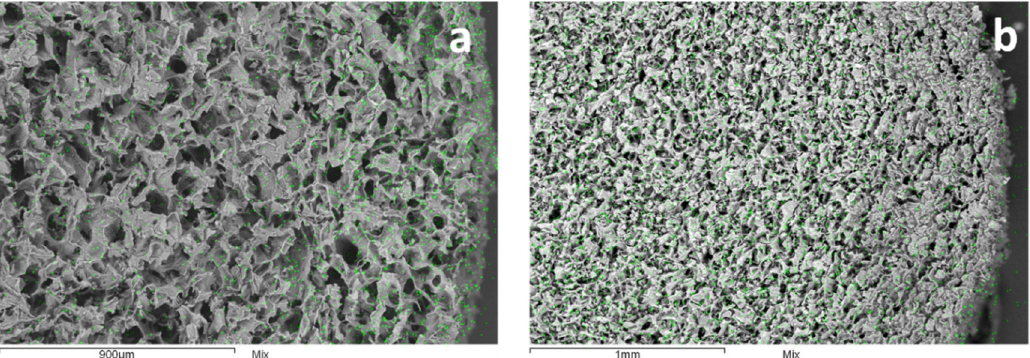
Figure 3. SEM–EDX (scanning electron microscopy–electron probe X-ray) image of a CNS cross-section after Zn(II) adsorption from 50 mg L − 1 ASW (left, a ) and 450 mg L − 1 (right, b ). Green dots represent metal ions.